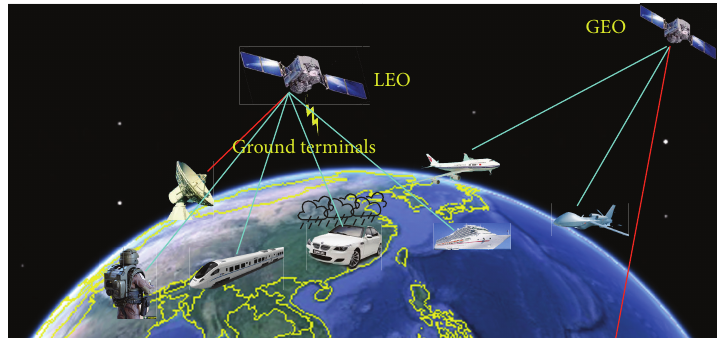
Figure 1: Various configurations and services of modern mobile satellite